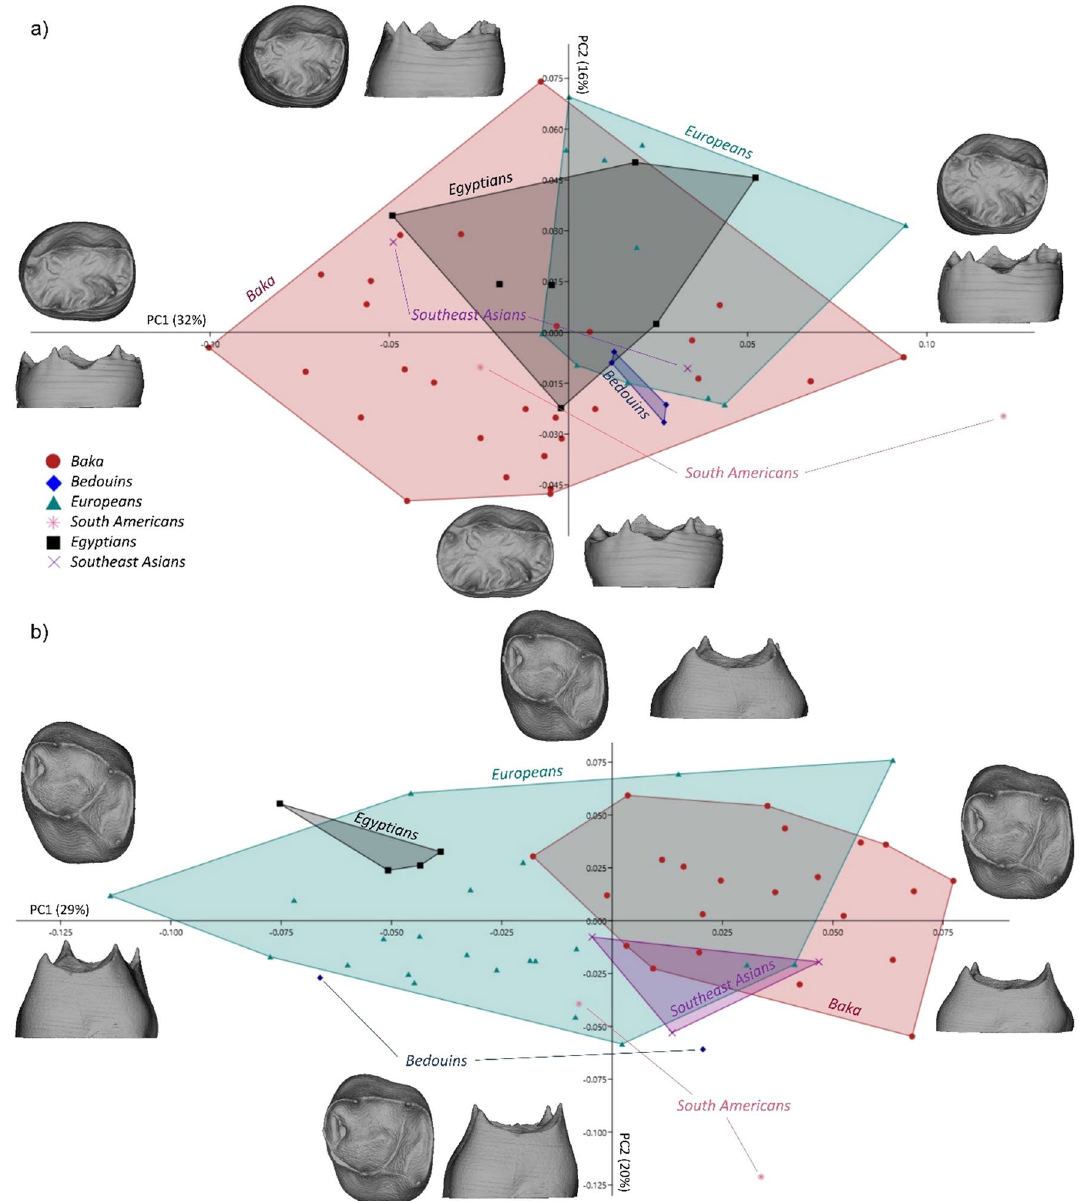
Figure 1. PCA plots for deciduous lower and upper second molar (ldm2 and udm2, respectively) dentinal crowns. ( a ) PC1—PC2 plot for ldm2s in shape space for the combined enamel-dentine junction (EDJ) and cervical outline (warpings at values ± 0.15/ ± 0.07). The Baka show a broader range of morphological variation than the Europeans; b) PC1—PC2 plot for udm2s in shape space for the combined EDJ and cervical outline (warpings at values ± 0.15). The Baka show a less variable morphology, while the Europeans exceed the range of